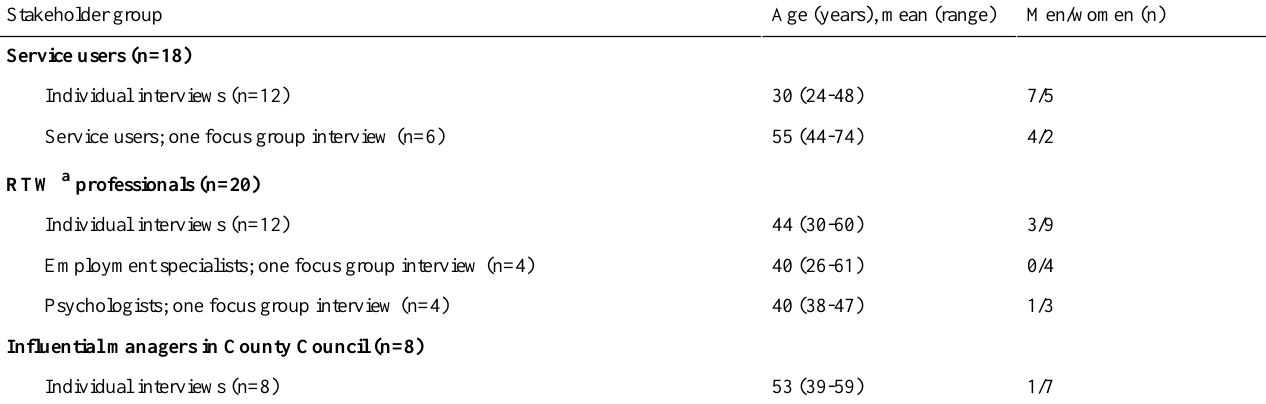
Table 1. Respondent characteristics